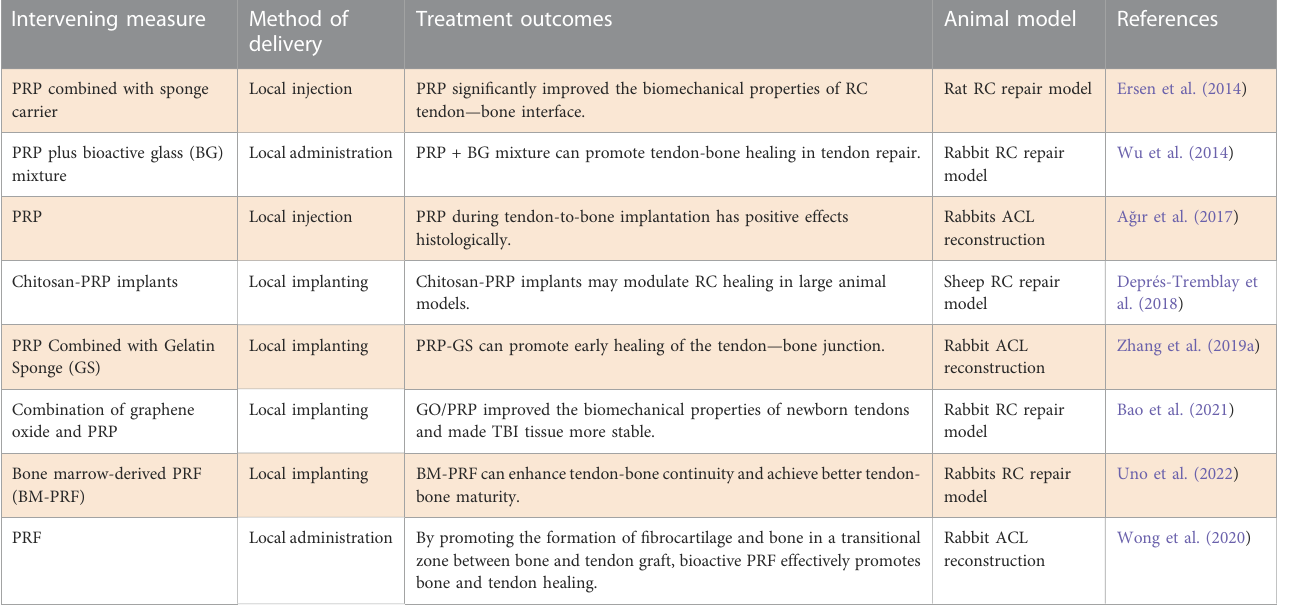
TABLE 4 Preclinical studies of platelet-rich application to promote tendon-bone